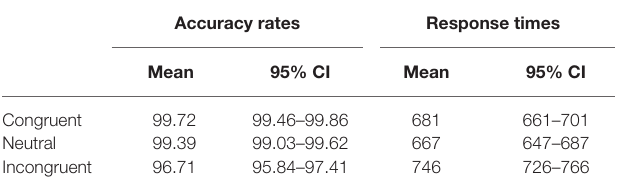
TABLE 5 | Mean accuracy rates in percentage (%), mean response times (ms) of correct trials and the 95% confidence intervals (CI) from the lower bond to the upper bond for the flanker task by Stimulus